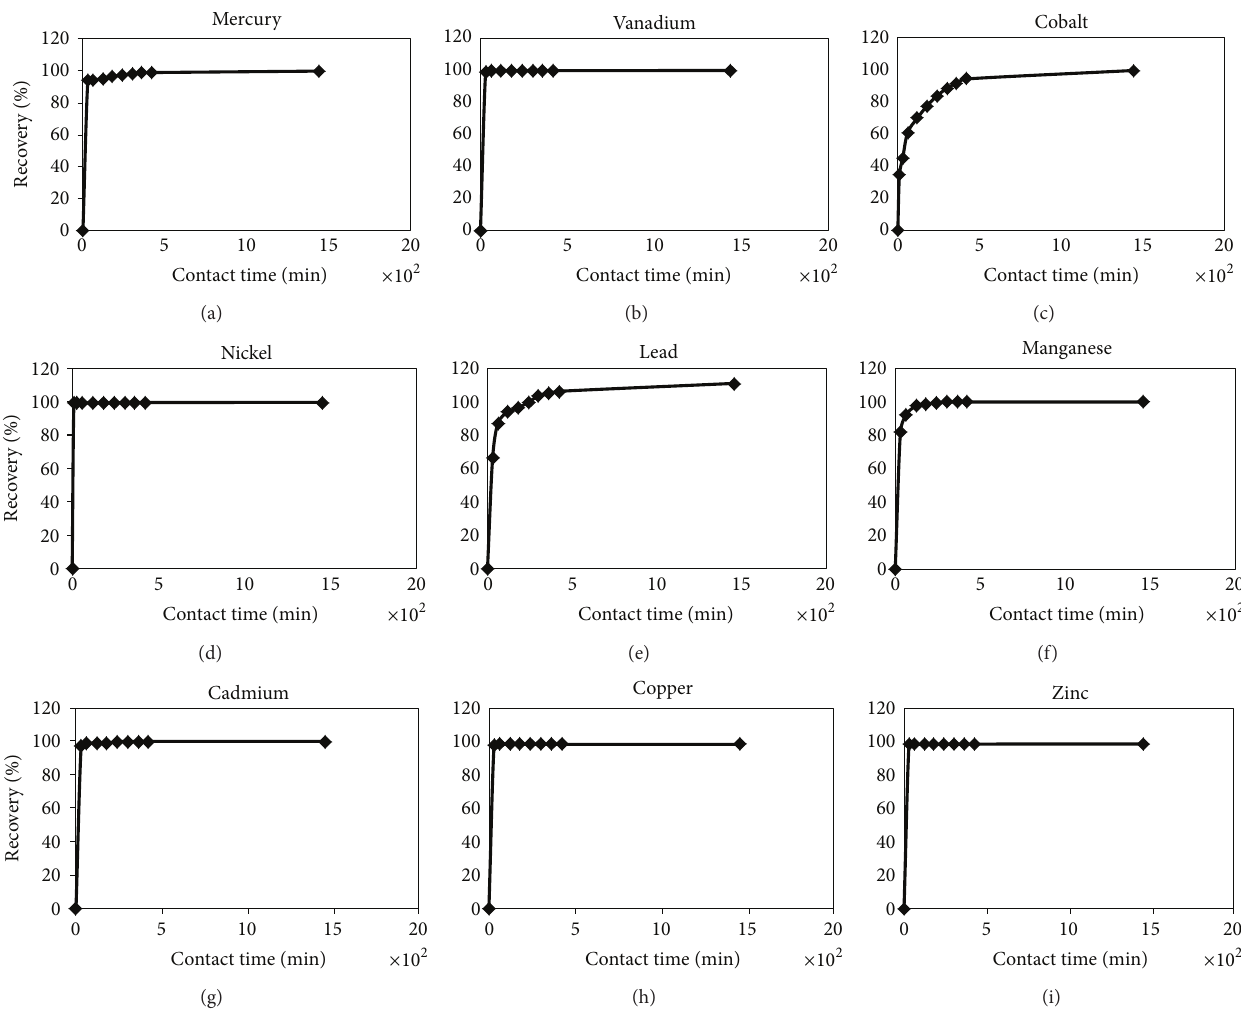
Figure2:Recoverypercentageofmetalsasfunctionoftimeinasingle-metalsolution.Conditions:volume:200mL,m(5Ph8HQ):1g,element optimized pH, and [M + ]: 1 𝜇 g mL −1